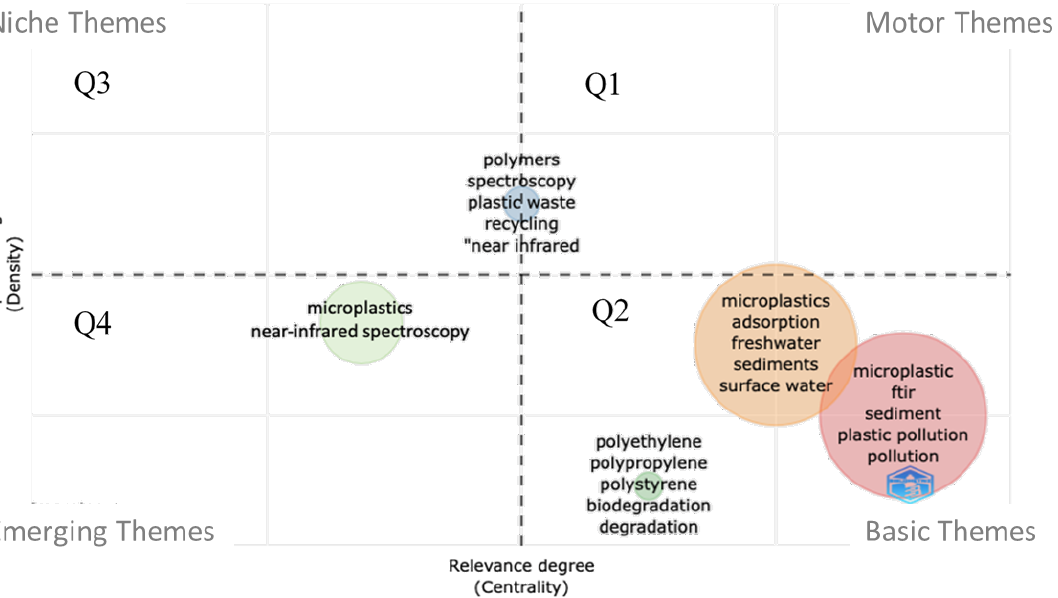
Figure 10. Thematic Map: FTIR- and NIR-related literature combined. The main theme is in Q1, followed by highly developed and specialized themes that connect to the main theme in Q2, fading or emerging themes in Q3, and foundational and transversal themes in Q4. The map was generated using the open-source tool Biblioshiny for Bibliometrix [38].